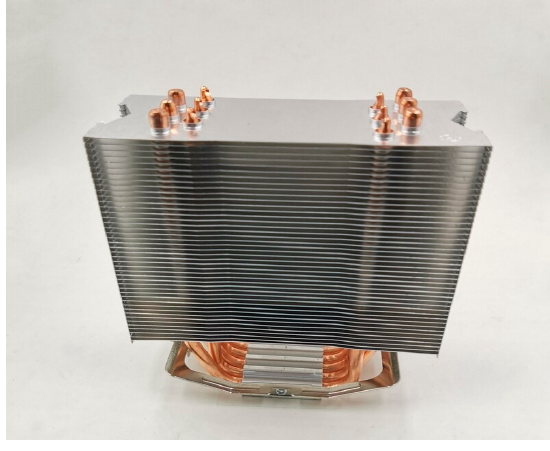
Figure 3. Fanless heat pipe sink.